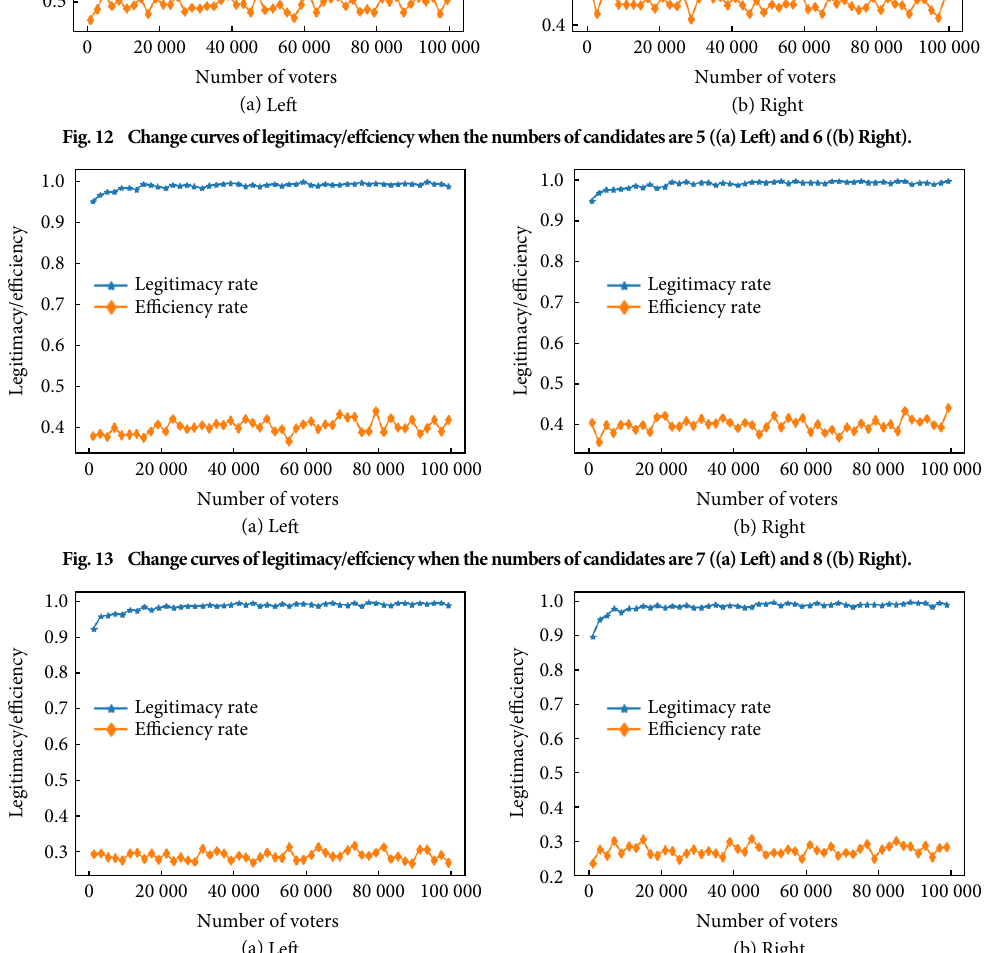
Fig. 14 Change curves of legitimacy/effciency when the numbers of candidates are 11 ((a) Left) and 12 ((b) Right).